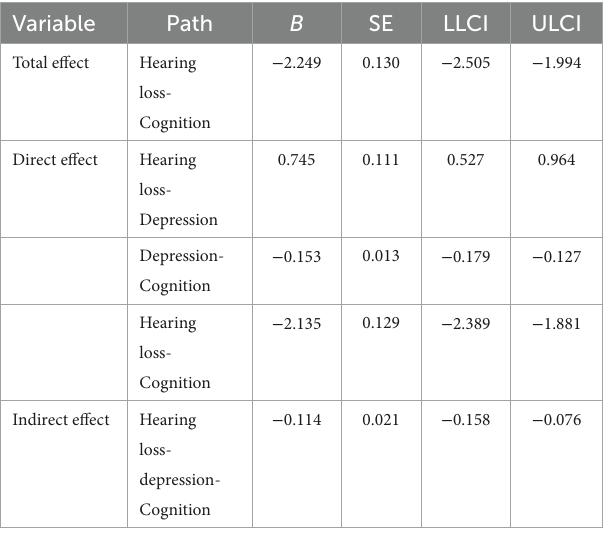
TABLE 4 Testing the mediating effect of hearing loss on cognitive